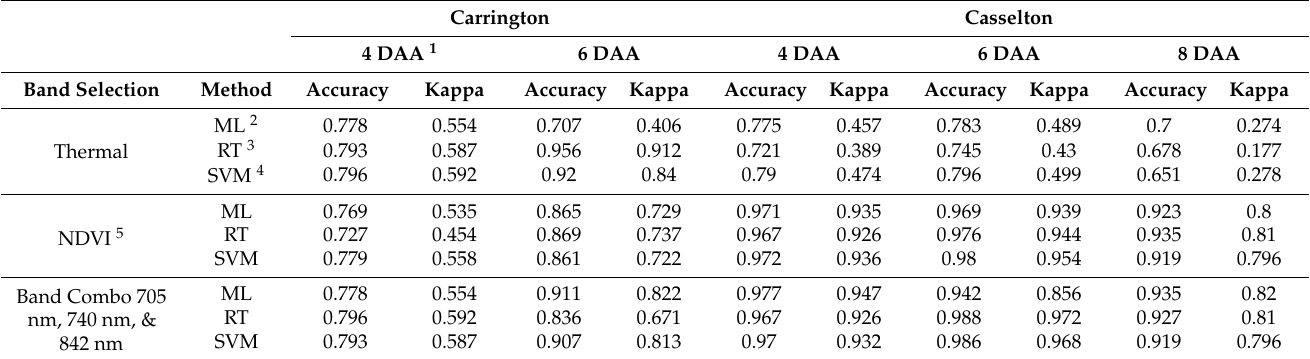
Table 7. Amaranth Classification Performance Summary.